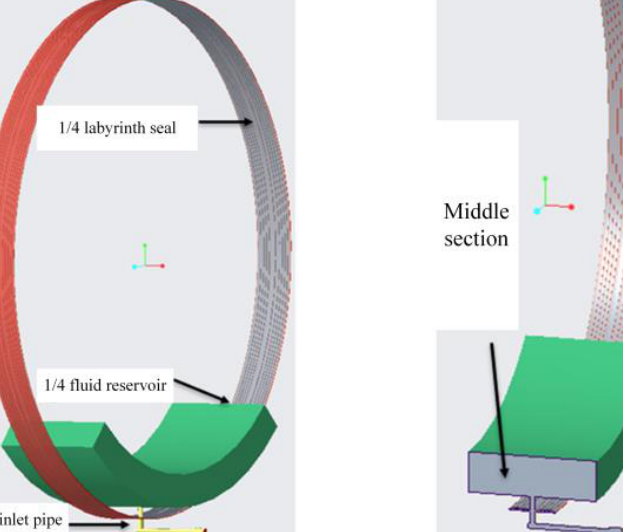
Figure 6. Computational fluid domain.